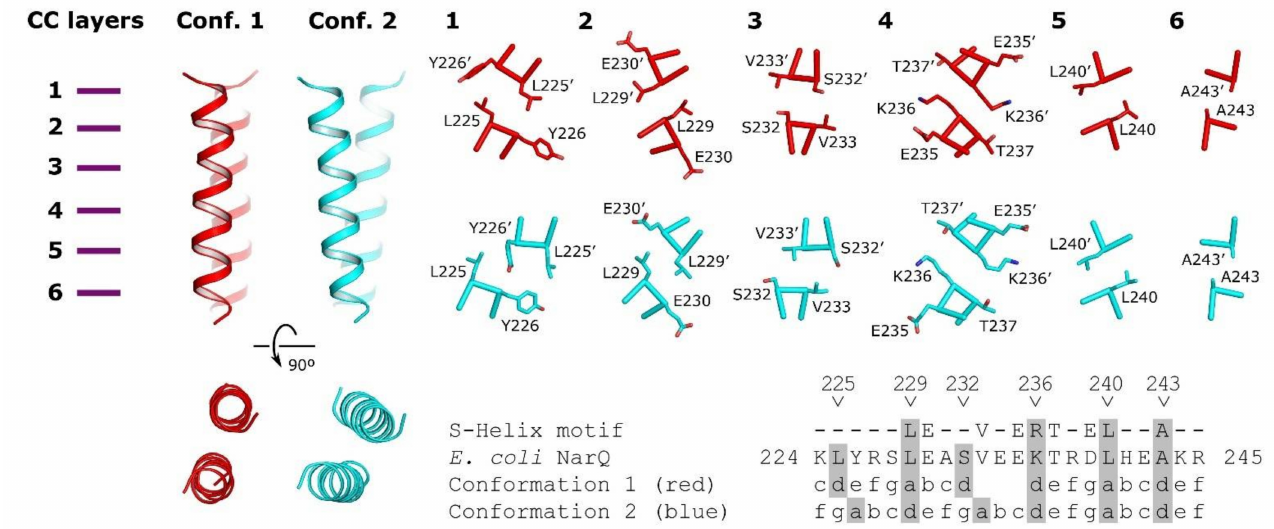
Figure 12. Coiled coil models of NarQ signaling helix domain. Two conformations are possible. Conformation 1 is shown in red and conformation 2 is shown in blue. The packing in layers 1–3 is different, while the packing in layers 4–6 is similar. The phase stutter is possible in the region of the residues 232–236. Residues Glu235, Lys236, and Thr237 belong to the characteristic conserved signaling helix motif (32). Reproduced with permission from